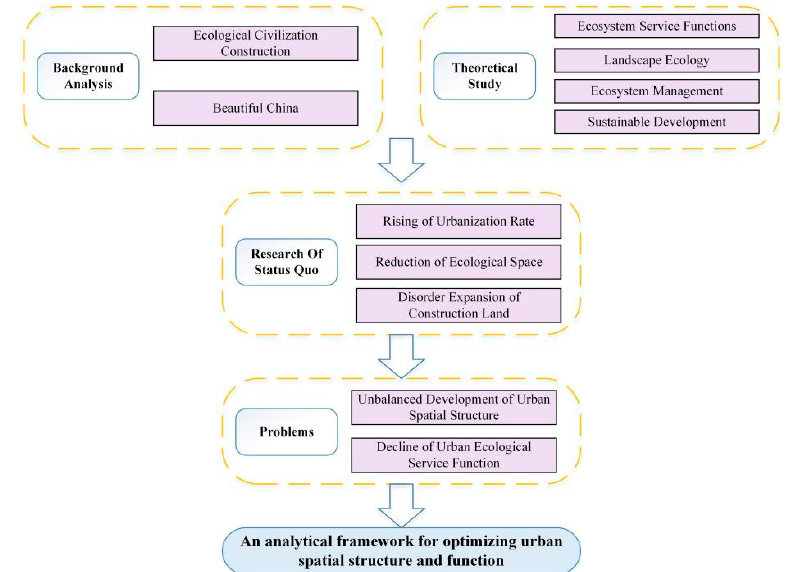
Figure 1. The theoretical framework.